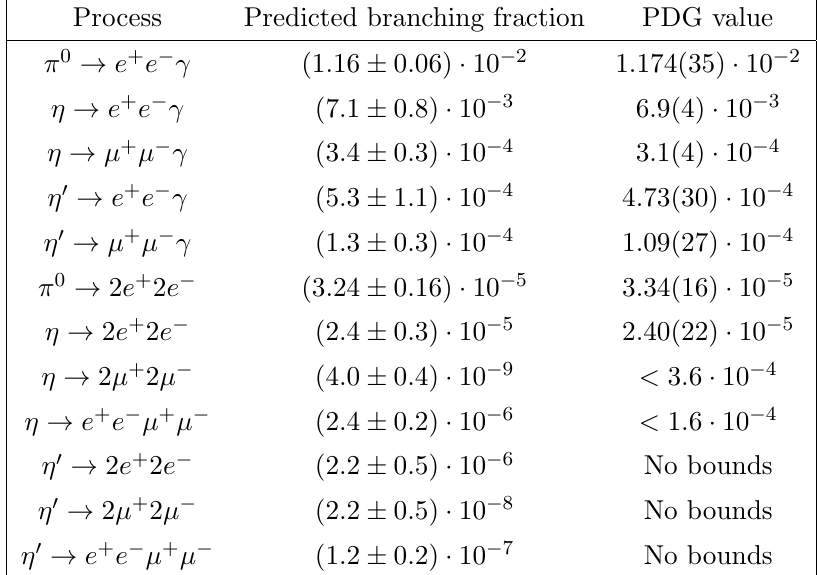
that the HLbL is determined by the various physical absorptive channels of the V V V V Green’s function of four electromagnetic currents. The lightest absortive cut is given by the meson pole topologies (cid:13) ? (cid:13) ? ! P ! (cid:13) ? (cid:13) ? . Additional intermediate states ( P P cuts, multiparticle states or with heavy resonances, etc.) will add further corrections to a HLbL